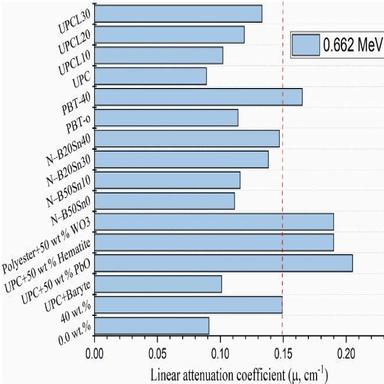
Comparison between the linear attenuation coefficient of the fabricated composites and those of previously reported polyester reinforced with various fillers.